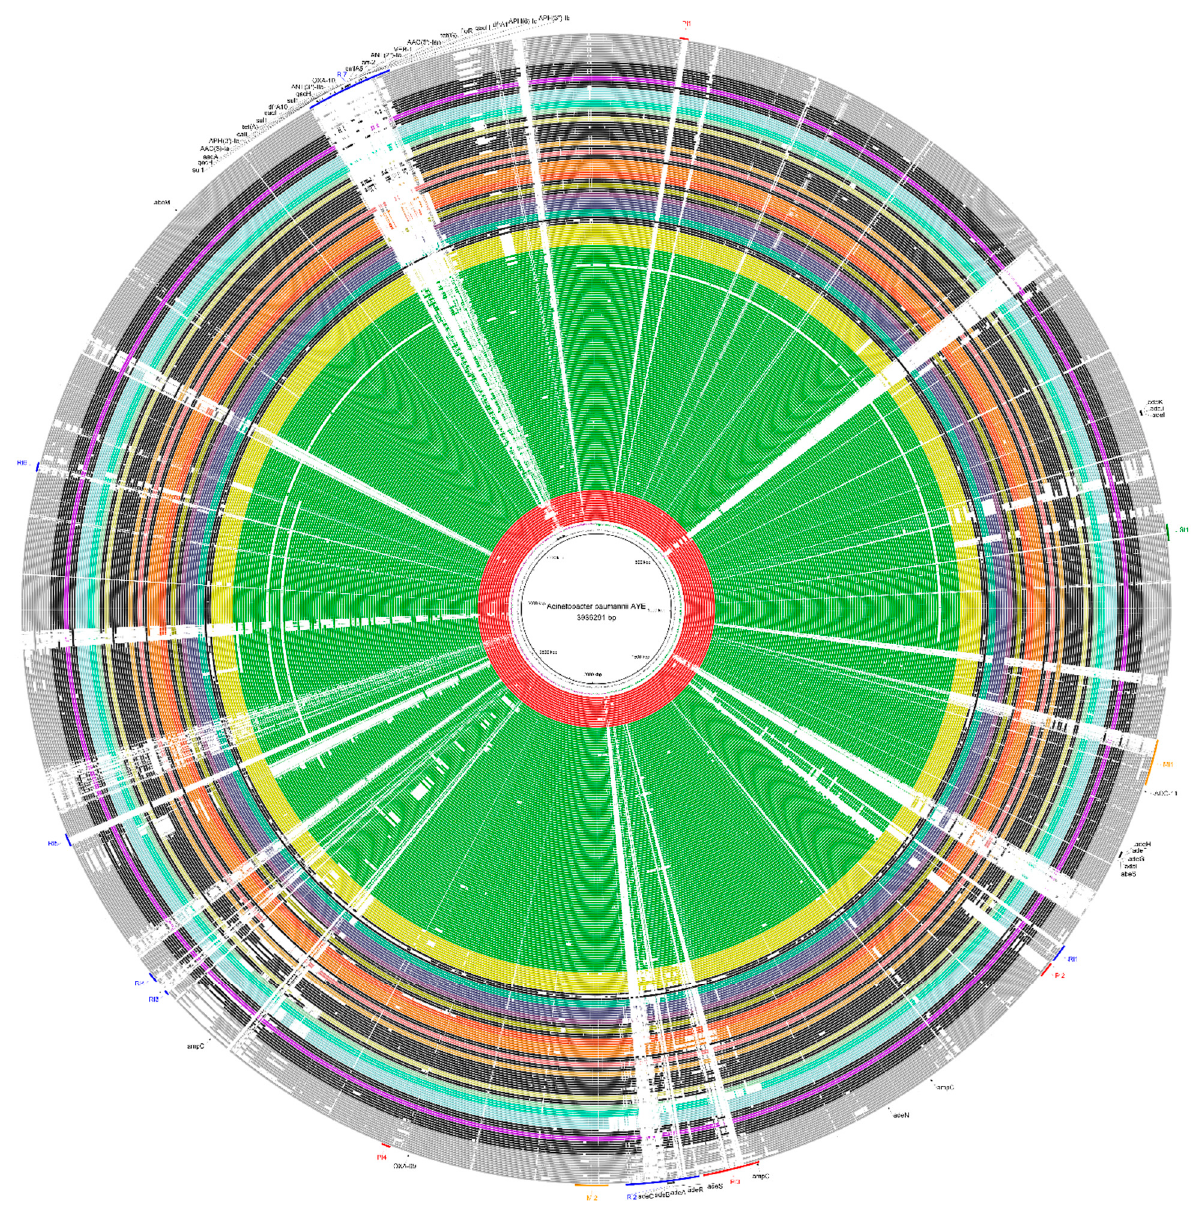
Figure 3. Representation of the circular genome of the A. baumannii AYE strain as a central genome. The compared strains were grouped and colored.